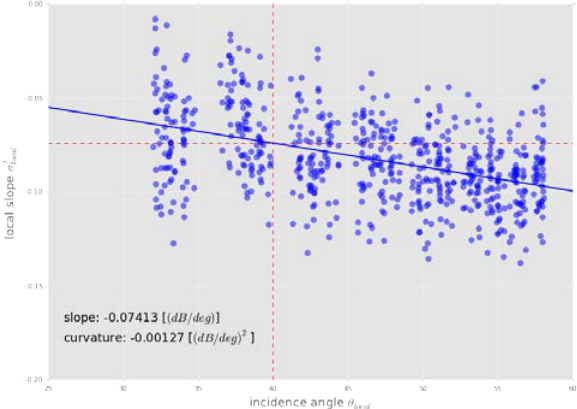
Figure 5: Estimation example of slope and curvature parameters by fitting a linear function to the so called local